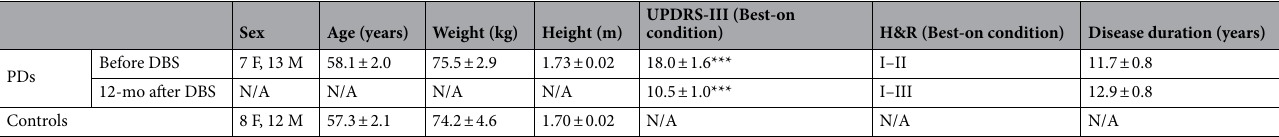
UPDRS-III (Best-on condition) H&R (Best-on condition) Disease duration (years)